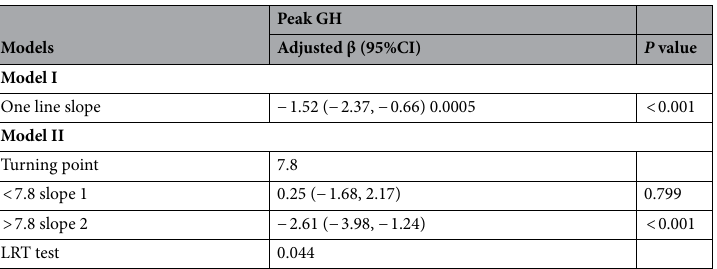
Table 3. The independent association between the TyG index and peak GH. Model I, linear analysis; Model II, non-linear analysis. LRT test, Logarithmic likelihood ratio test. ( p value < 0.05 means Model II is significantly different from Model I, which indicates a non-linear relationship); Adjustment variables: age, sex, BMI, TC, pubertal stage. BMI: body mass index, TC: total cholesterol; P < 0.05 is considered to be statistically